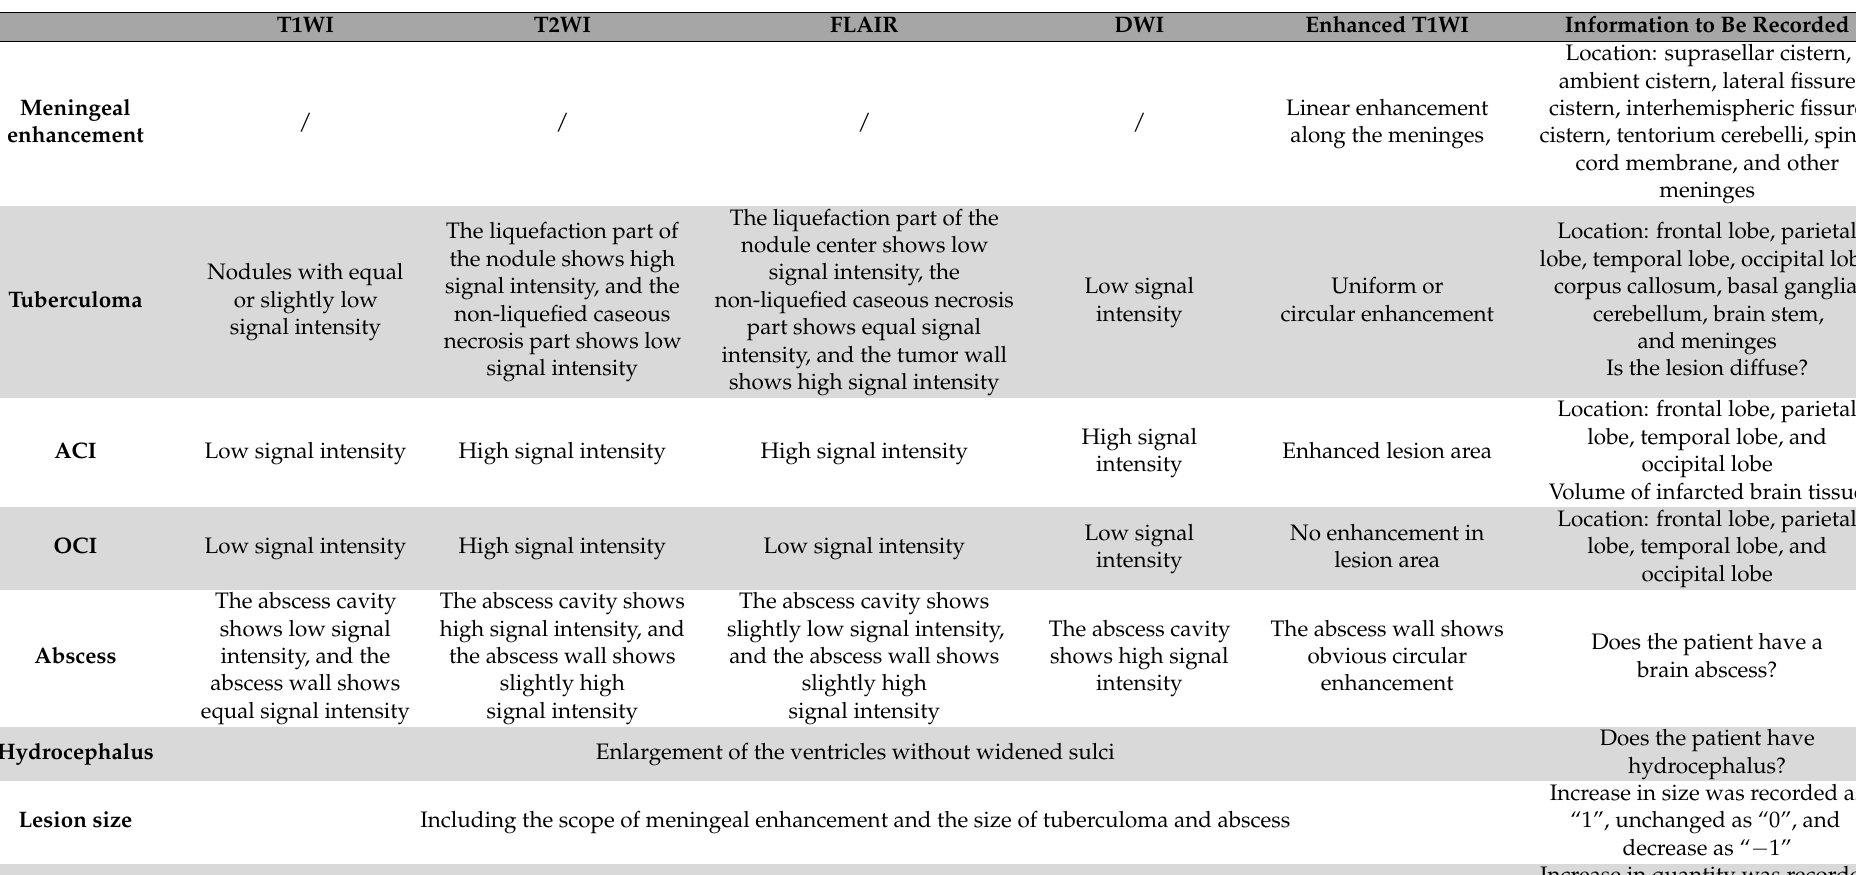
Table 1. The characteristics of TBM and its complications on each MRI sequence image and the feature information to be